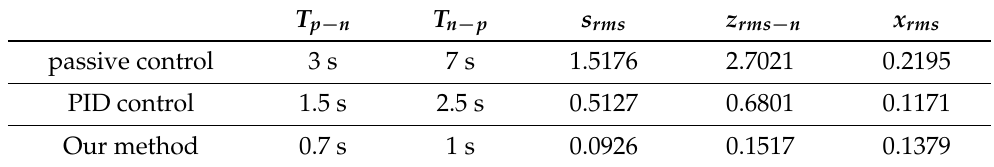
Figure 11. Suspension performance in simulation. ( A ) Sprung speed from H -level road to D -level road. ( B ) Sprung speed from C -level road to H -level road. ( C ) Tire deflection from E -level road to G -level road. ( D ) Suspension deflection for the first 30 s. Table 6. Performance of suspension in